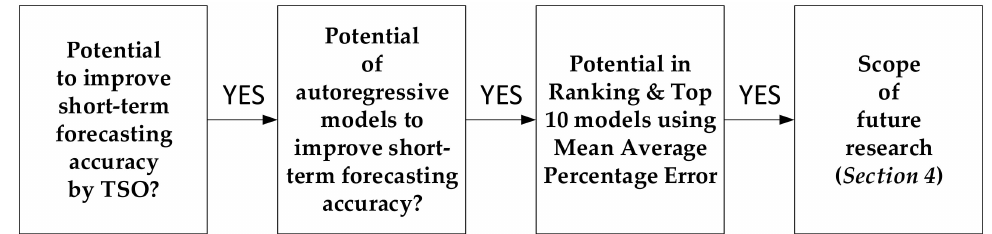
Figure 1. The design of the survey. Table 2. Forecasting model ranking for the position from 1 to